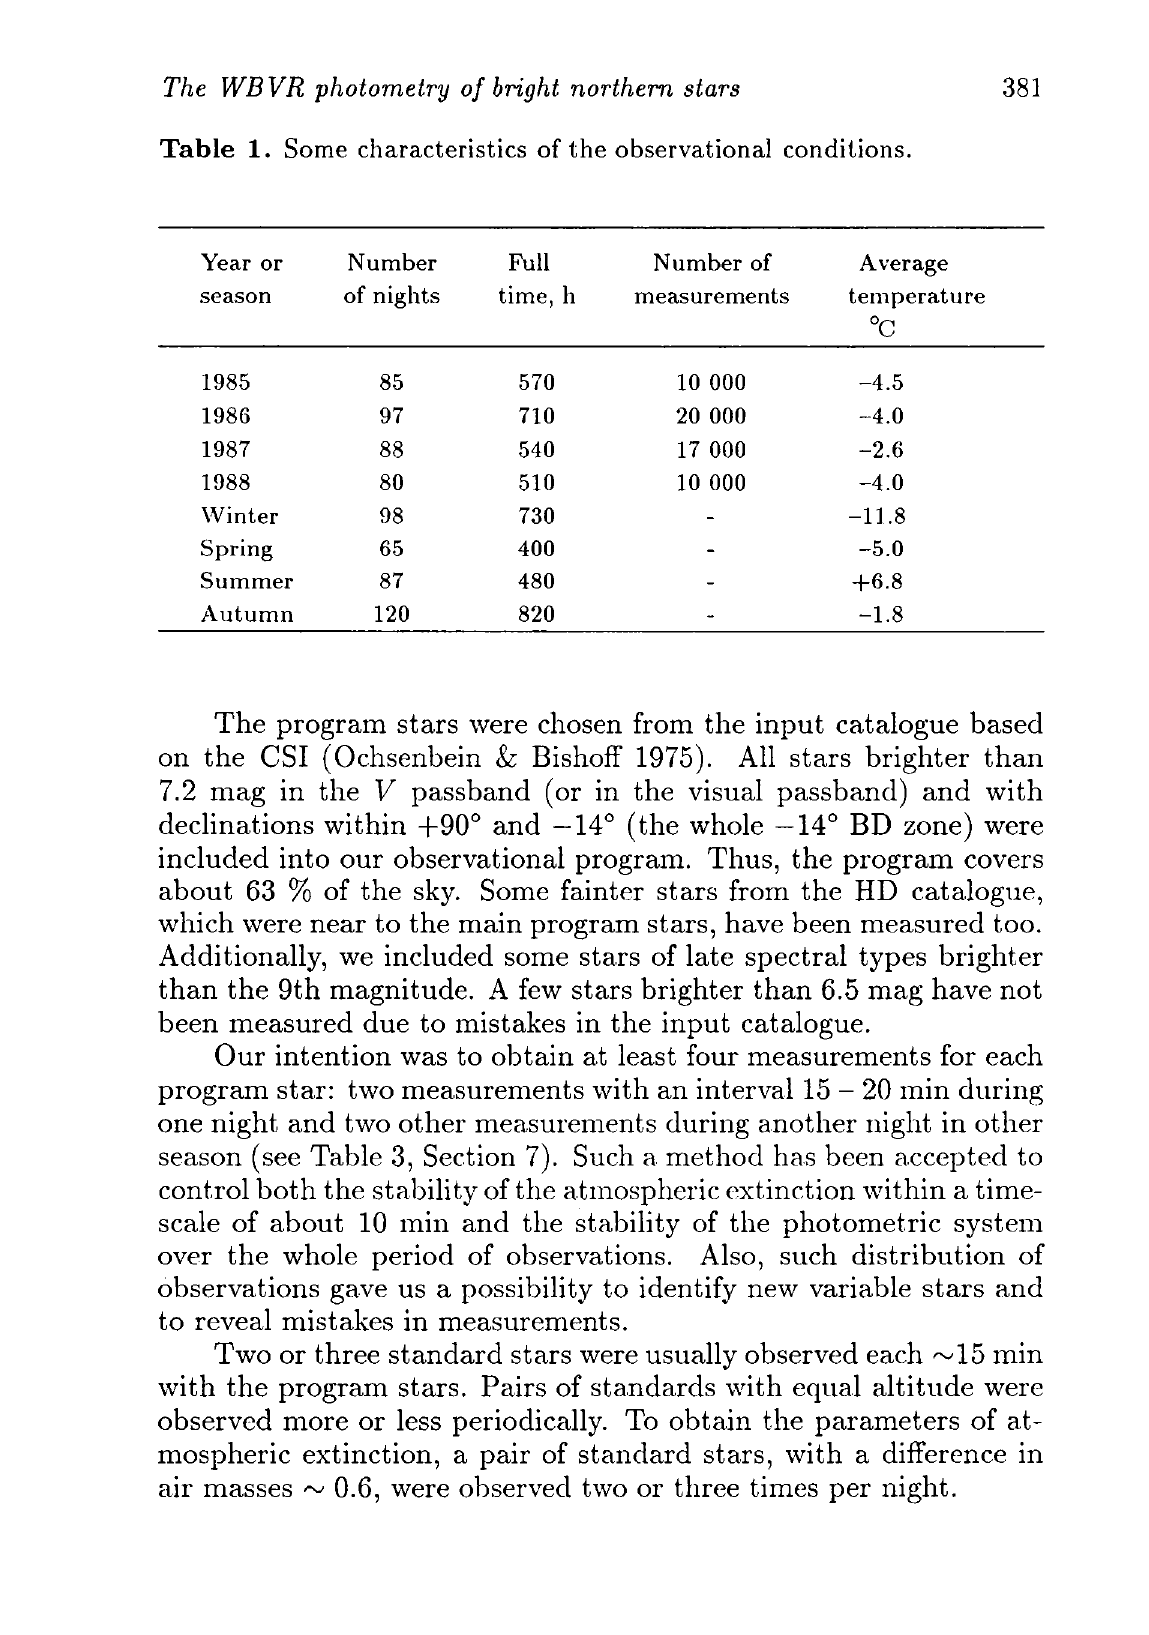
Table 1. Some characteristics of the observational